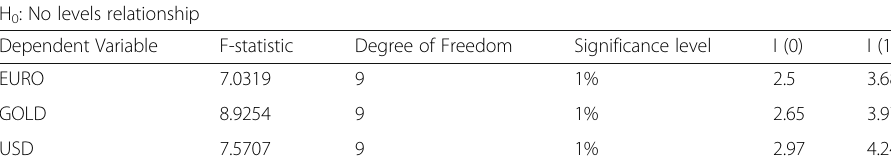
Table 3 Bounds test